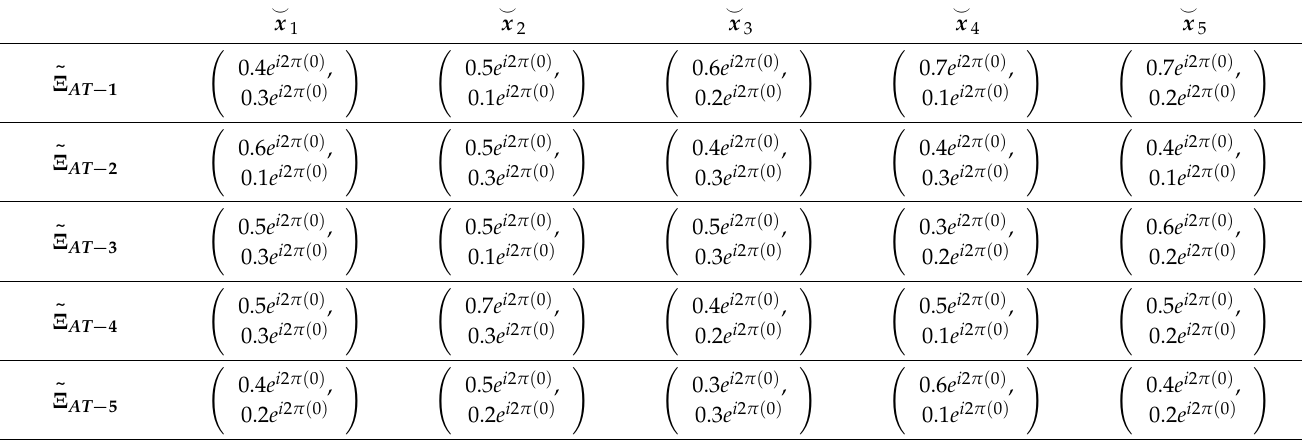
Table 8. Original decision matrix for candidates (cid:101) Ξ CI − 2 .